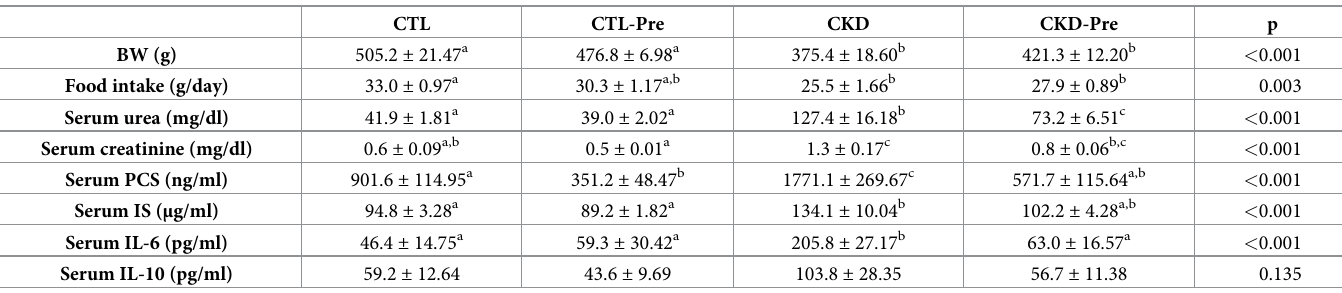
Table 1. Physiological and biochemical